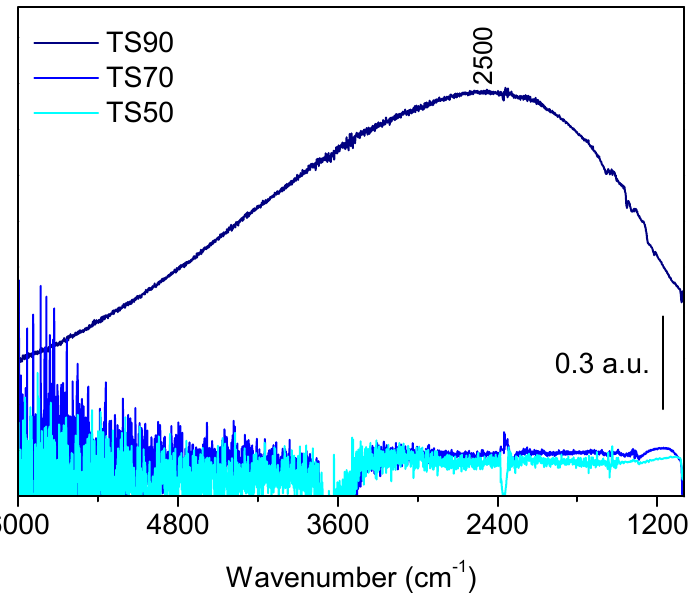
Figure 6. IR spectra recorded during CO (20 mbar) interaction at 200 °C for TS90 and at 400 °C for TS70 and TS50.